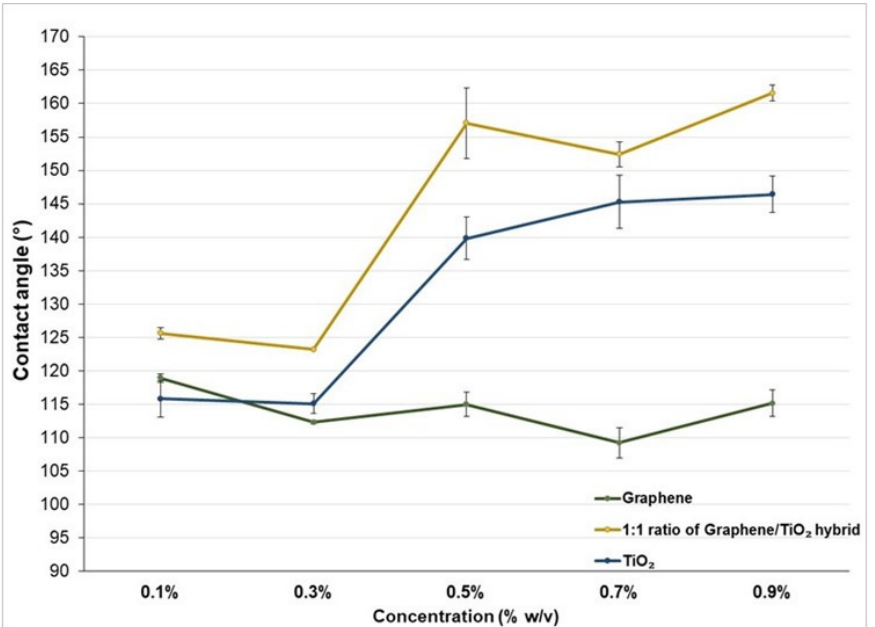
Figure 3. Comparison between the apparent contact angle of 0.1% w / v , 0.3% w / v , 0.5% w / v , 0.7% w / v , and 0.9% w/v of the graphene/TiO 2 coating.